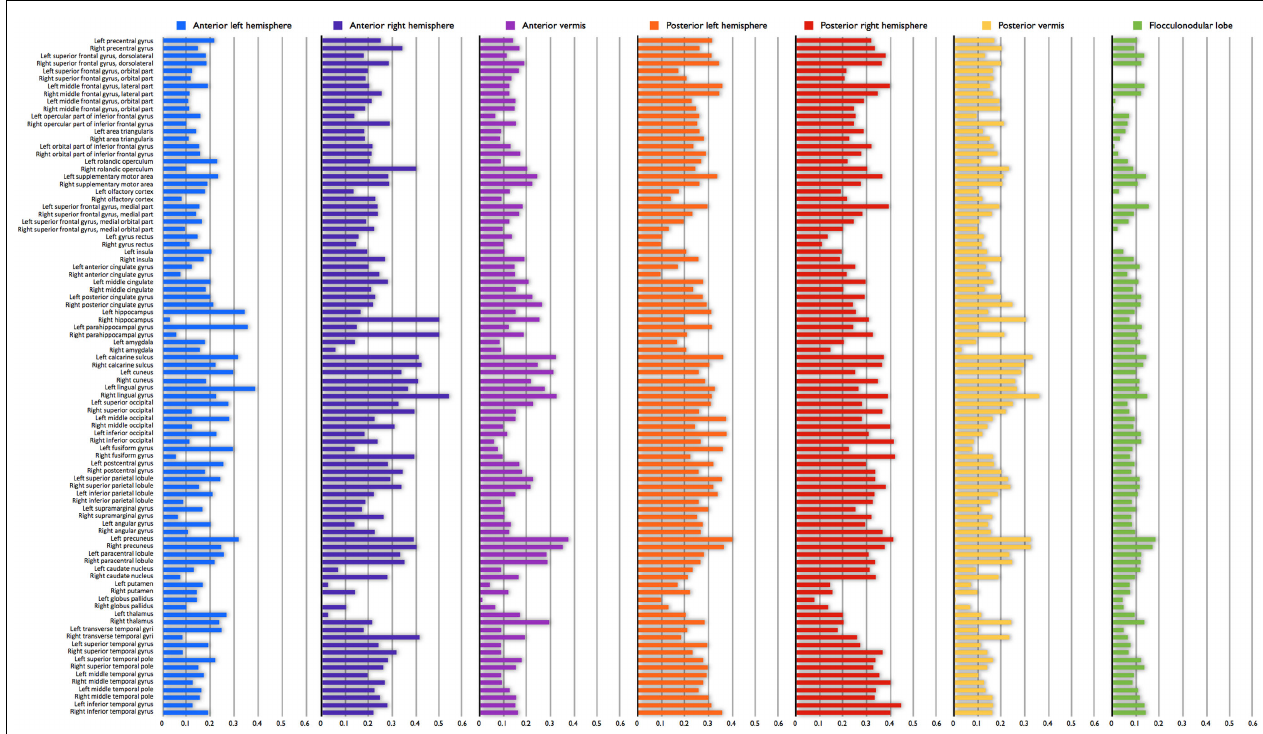
high interregional functional connectivity; low correlations indicate low interregional functional connectivity. Negative correlations ( N = 4; mean (SD) [range] =− 0.05 (0.18) [ − 0.07 to − 0.02]) are depicted as